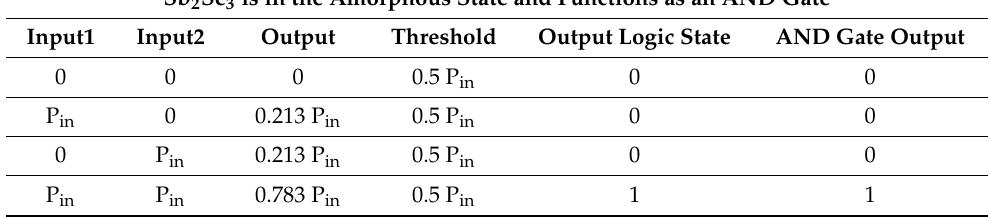
Table 2. Truth table for the all-optical AND logic